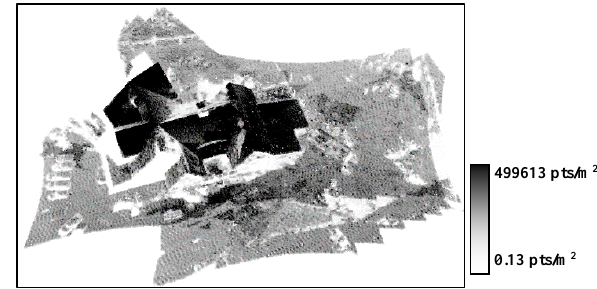
Figure 4. The point density map of a generated 3D point cloud for the identification of data